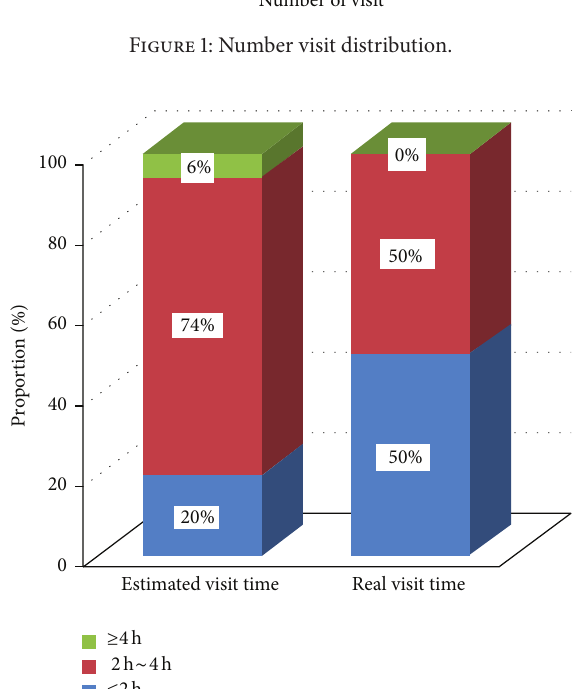
Figure 2: Comparison between tour budget time and real visit